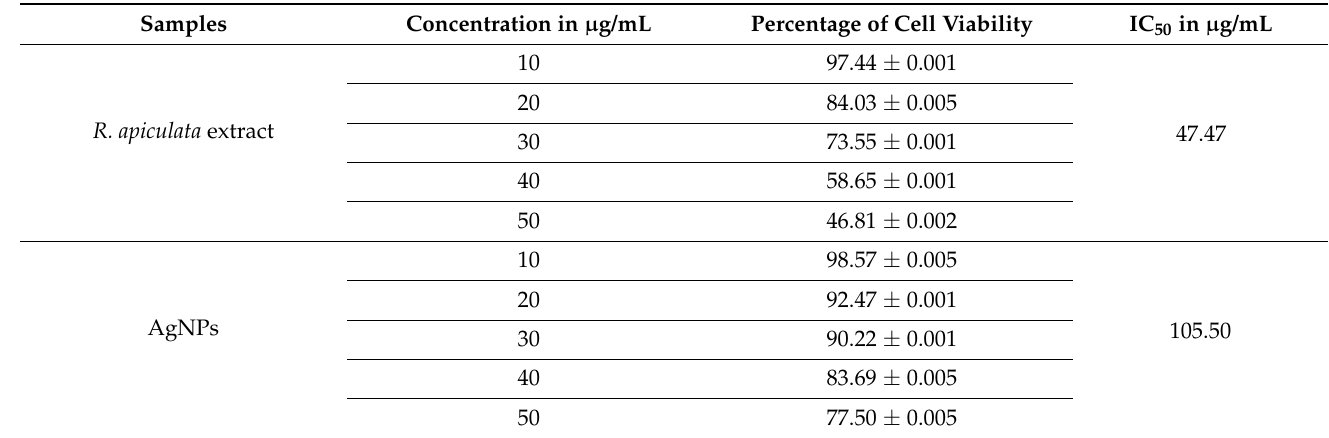
Table 7. Cytotoxicity of aqueous leaf extract of R. apiculata and its synthesized AgNPs against L929 cell line.